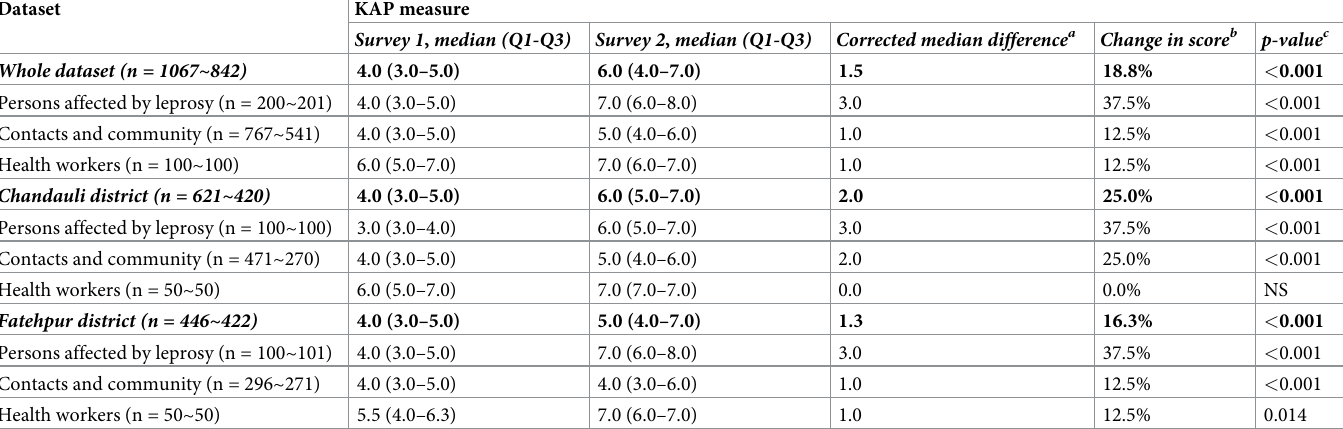
Table 3. Corrected median differences in KAP (range 0–8) scores between Survey 1 (n = 1067) and Survey 2 (n =